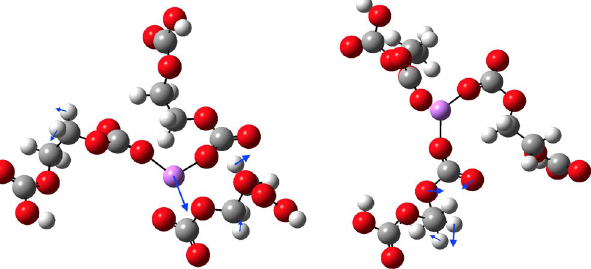
Figure 9. Vibrational modes due to prominent Li + movement (left 436 cm − 1 ) and solvent motion around 700 cm − 1 (right). Li + is surrounded by 3 EDC molecules. Adjacent carbonyl and ether oxygen of the same EDC molecule interact with Li + (left). The Gaussian09 24 software was used for these calculations with the b3lyp exchange-correlation density functional and 6–31 + g (d, p) basis set. The structures were sampled from the classical MD simulations and then the carboxyl groups not coordinating with the Li + ions were neutralized by adding hydrogen atoms. The blue arrows indicate the atomic displacements for these normal mode frequencies 25